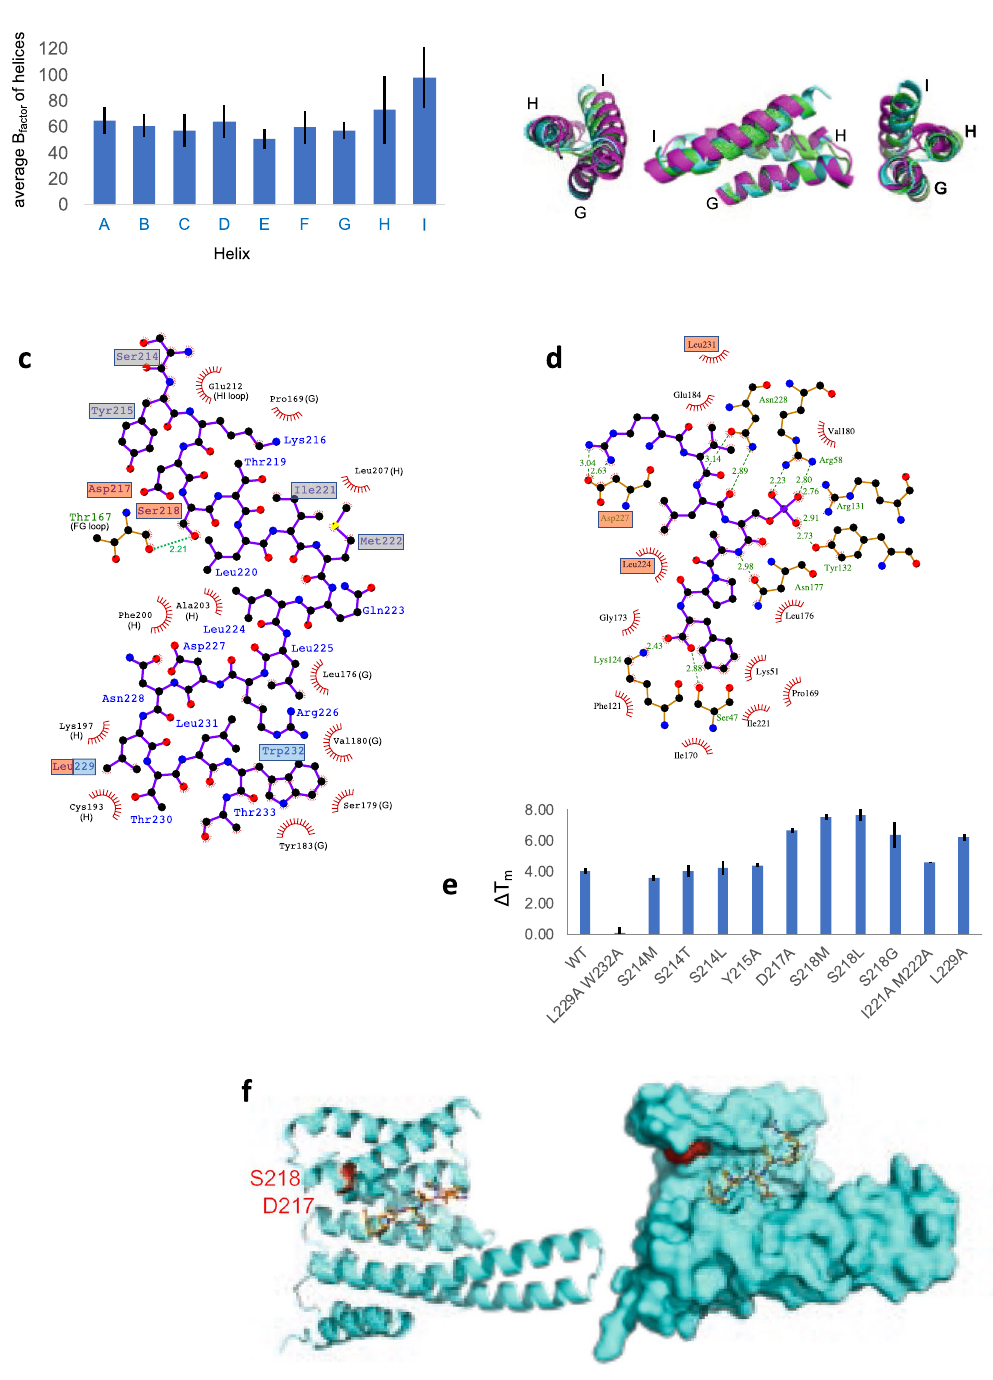
Figure 4. The flexibility of St14f helix I. ( a ) Average B-factors of each helix of St14f chain B. ( b ) Superposition of three chains of C-terminal helices G-I St14f in the crystal. They were fixed to helix G, which showed a relatively low B-factor. ( c ) Interaction diagram of St14f helix I and other helices generated by LigPlot+. The letters followed by the residue number show the helix or loop name. The hydrogen bonds are shown as the dotted line, while the hydrophobic contacts are represented by an arc with spokes. ( d ) Model of the StFDL1 peptide and St14f binding diagram based on the GF14c-OsFD1 structure. The residues involved in the interaction between the StFDL1 peptide and St14f helix I are represented in red. ( e ) Results of the thermal shift assay. The temperature changes caused by mutation are shown. ( f ) Mapping of the stabilized residues on the St14f surface that were revealed by thermal shift assay. The StFDL1 peptide is represented by an orange ball and stick model. Figures are prepared by PyMol 2.6 (http:// www. pymol. org/ pymol) 42 and LigPlot+ 2.2 (https:// www. ebi. ac. uk/ thorn ton- srv/ softw are/ LigPl us/) 27